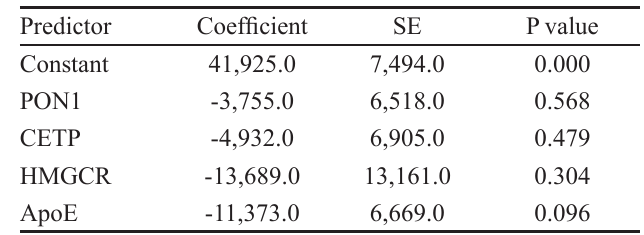
FIGURE 2 - Classification of studied individuals (n=55) according to cluster analysis and characterization of the three clusters based on nutrient intake, blood biochemistry and polymorphisms in PON-1, HMGCR, CETP and APO E genes. SAFA - saturated fatty acids; MUFA - monounsaturated fatty acids; PUFA - polyunsaturated fatty acids; ORAC - oxygen radical absorbance capacity; FRAP - ferric-reducing antioxidant power; DPPH - 2,2-diphenyl-1-picrylhydrazyl radical; MDA - malondialdehyde; oxLDL - oxidized low density lipoprotein; HDL - high density lipoprotein; PON1 - paraoxonase 1; HMGCR - 3-hydroxy-3-methylglutaryl- coenzyme A reductase; CETP - cholesterol ester transfer protein; ApoE - apolipoprotein E; M - mutant gene; WT – wild-type. P values obtained by ANOVA: α-tocopherol (p=0.316), γ-tocopherol (p=0.006), δ-tocopherol (p=0.003), ORAC (p=0.001), FRAP (p <0.001), DPPH (p= 0.004), MDA (p=0.052), oxLDL (p=0.145) and CHOL nHDL (p=0.208). Means for the same variable with different superscript letters are significantly different, p<0.05. TABLE III - Coefficients of the linear models adjusted to Principal TABLE IV - Coefficients of the linear models adjusted to Component 1 response (antioxidant activity response)